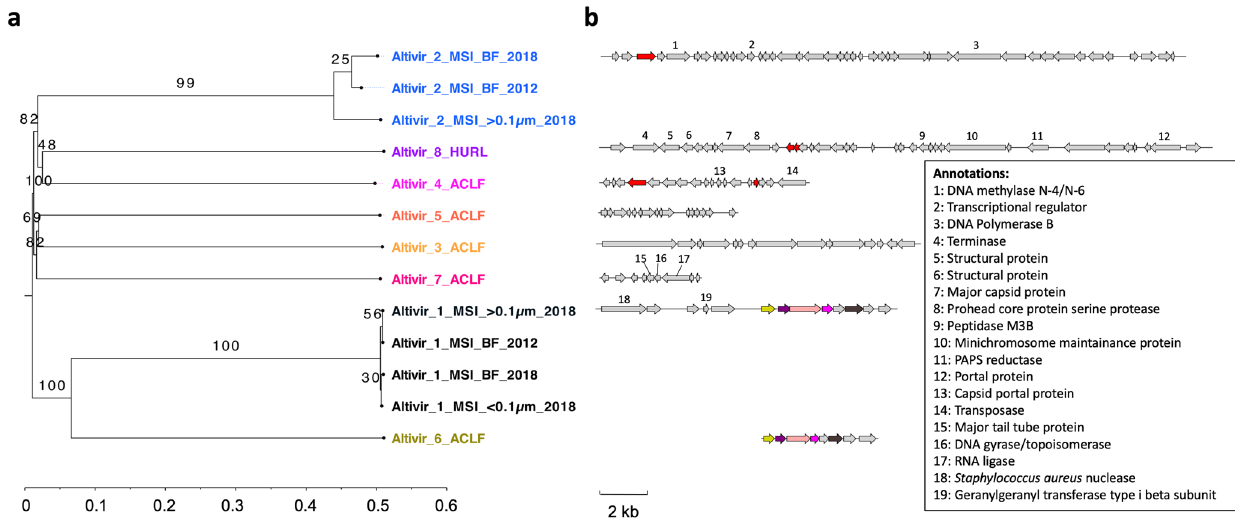
Fig. 2 Phylogenomic genome-BLAST distance phylogeny (GBDP) tree of Ca. Altiarchaeum viruses and viral proteins clusters. a The tree was inferred using the distance formula D0 yielding average support of 69%. The numbers above branches are GBDP pseudo-bootstrap support values from 100 replications. The branch lengths of the resulting VICTOR 94 trees are scaled in terms of the respective distance formula used. The tree shows that the eight predicted viral genomes were assigned to the same family, to eight different genera, and ten species (which is the result of having multiple genomes included for Altivir_1_MSI and Altivir_2_MSI). b Protein clustering across all viruses revealed that Altivir_1_MSI_>0.1 µ m_2018 and Altivir_6_ACLF, originating from different continents, have fi ve protein clusters (2 – 6) in common. Altivir_2_MSI_BF_2012, Altivir_4_ACLF, and Altivir_8_HURL shared only one protein cluster (1). Open reading frames of the viral genomes were predicted using Prodigal v.2.6.3 74 and further translated with the R package seqinr v.3.6.-1. Colors indicate shared protein clusters between genomes and numbers show nonhypothetical consensus annotations according to Supplementary Data 3. Color code for viral genomes: Altivir_1_MSI = black, Altivir_2_MSI = blue, Altivir_3_ACLF = yellow, Altivir_4_ACLF = pink, Altivir_5_ACLF = orange, Altivir_6_ACLF = olive-green, Altivir_7_ACLF = pink-red, and Altivir_8_HURL =